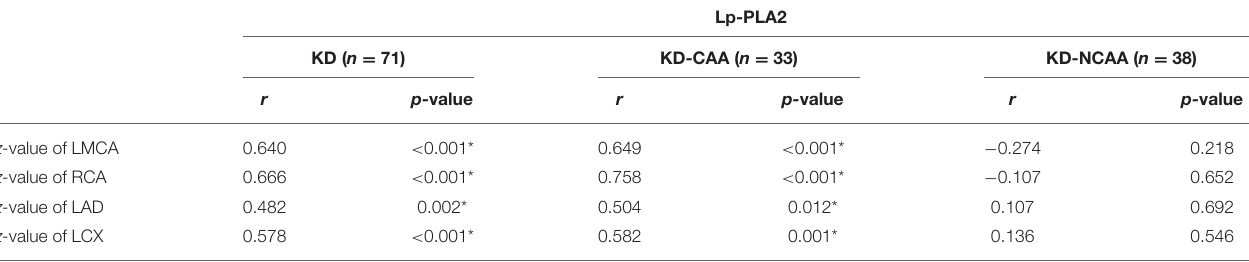
TABLE 4 | Correlations between serum Lp-PLA2 levels and Z- value.